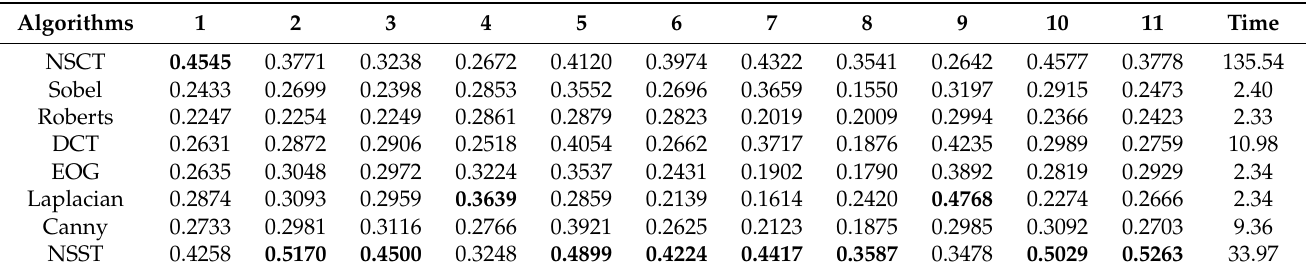
Table 1. Comparison of narrow widths of noise-free images in different algorithms. The maximum value is given in bold.